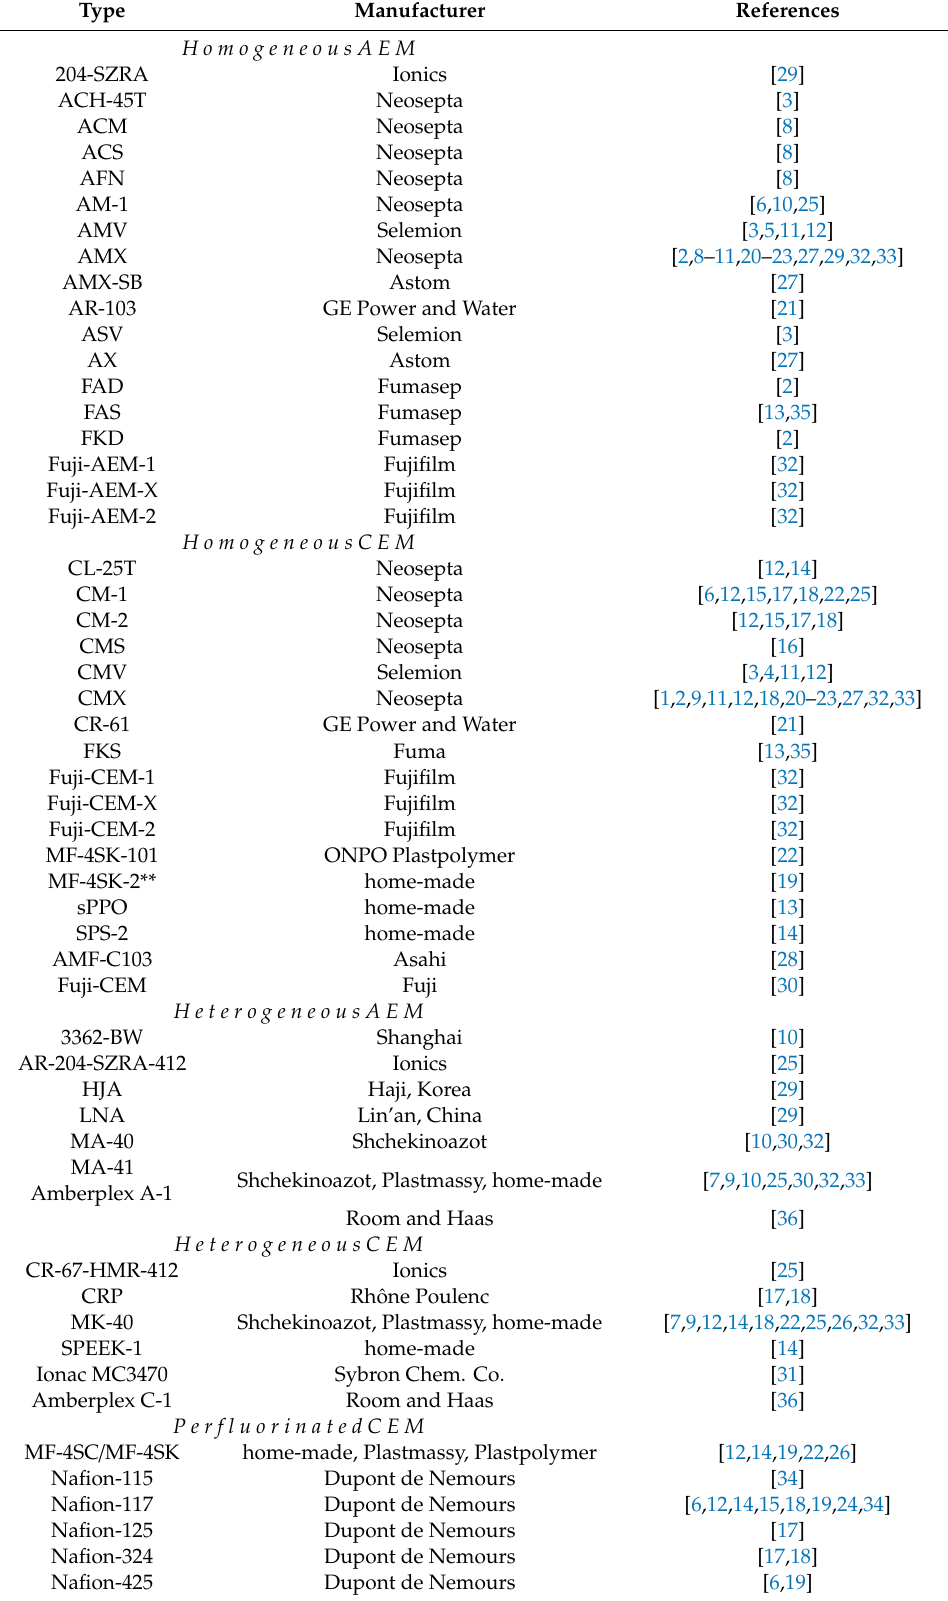
Table 4. Acquired datasets from the literature. AEM: anion exchange membranes, CEM: cation exchange